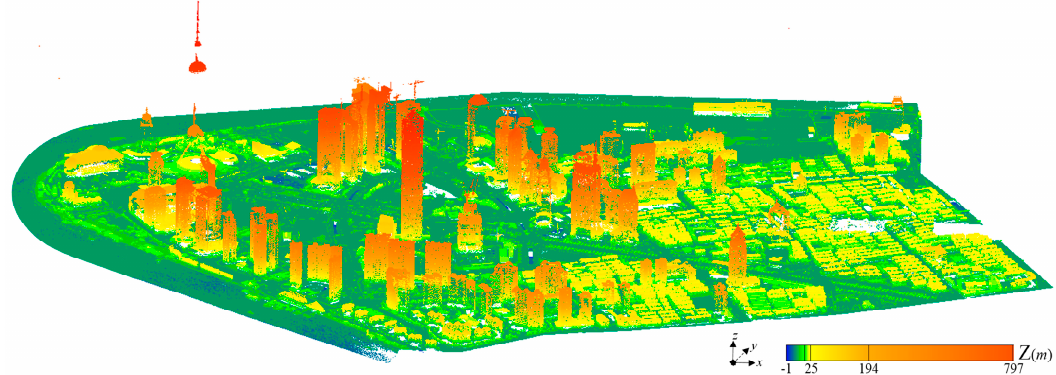
Figure 5. The georeferenced point clouds of the Lujiazui region.